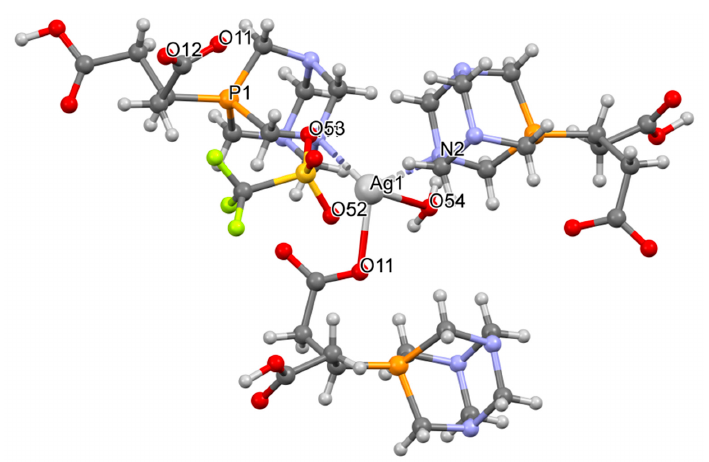
Figure 7. Partial packing view of CP1.1 Selected bond lengths (Å): Ag1–O11 = 2.294(3), Ag1–N2 (i) = 2.439(3), Ag1–N1 (ii) = 2.465(3), Ag1–O54 = 2.691(4), P1-O11 = 2.798(3), P1–C12 = 1.818(4), Ag1–O12 =